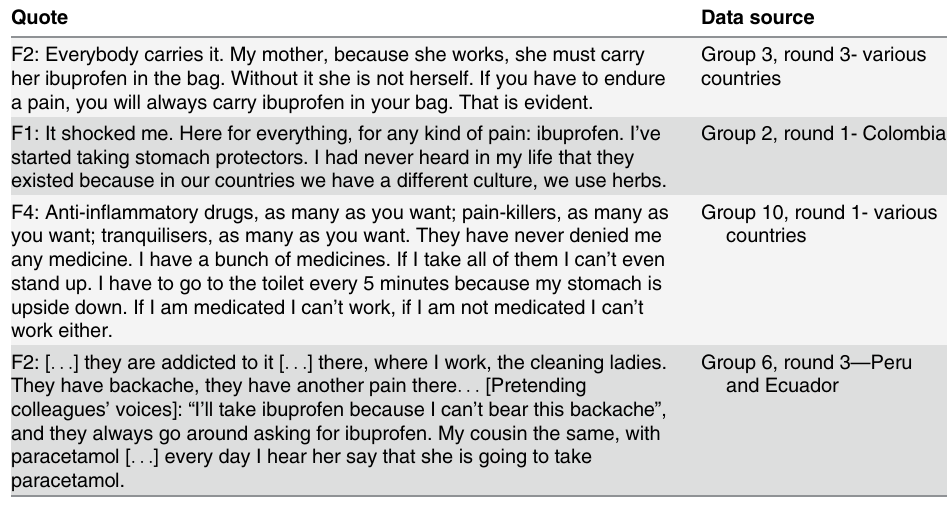
Table 3. Medicated lives: “ I carry ibuprofen in my bag ”